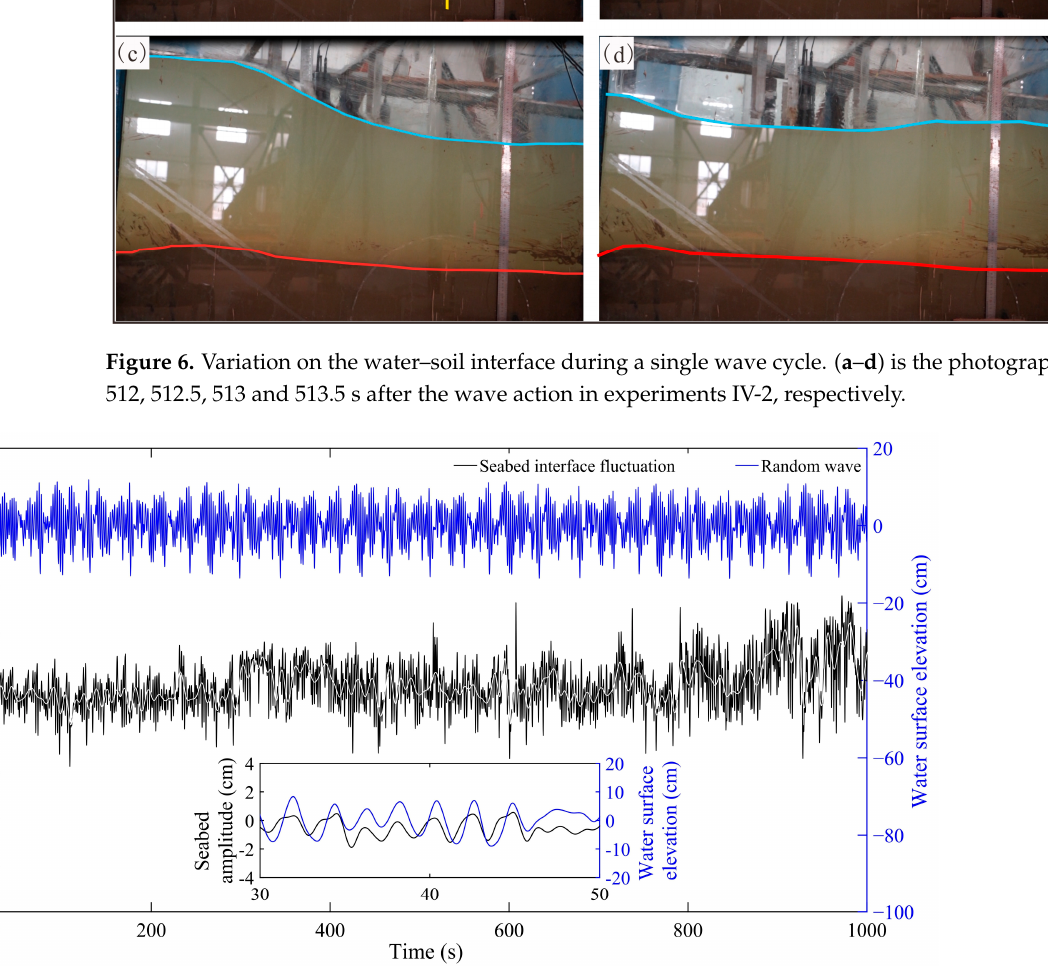
Figure 7. Fluctuation of mud waves along with water waves through time: blue curve—random waves; black curve—seabed interface.